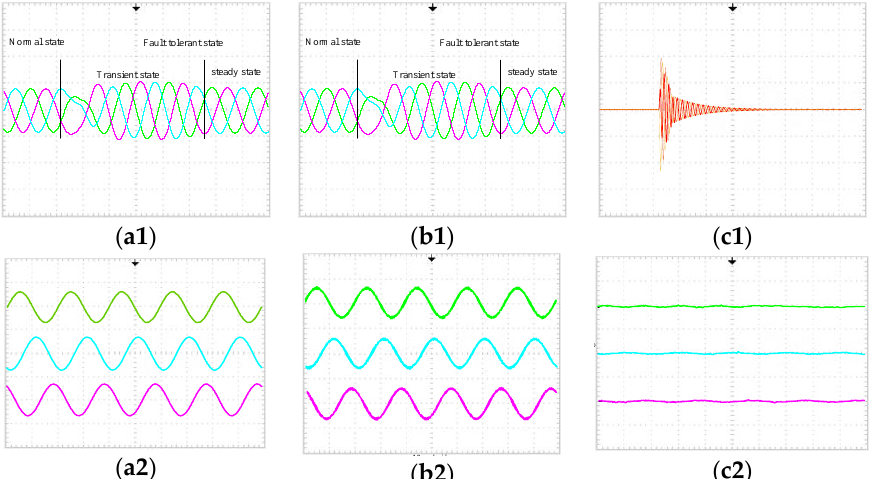
Figure 10. The experimental results of the reconfigurable inverter under faulty V 1 ( a1 ) dynamic output voltages; ( a2 ) steady output voltages; ( b1 ) dynamic currents; ( b2 ) steady currents; ( c1 ) dynamic voltage deviation; ( c2 ) steady voltage deviation.